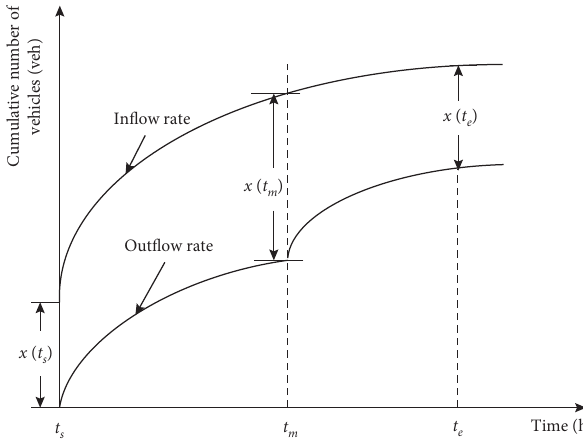
Figure 2: Schematic diagram of road traffic volume change after